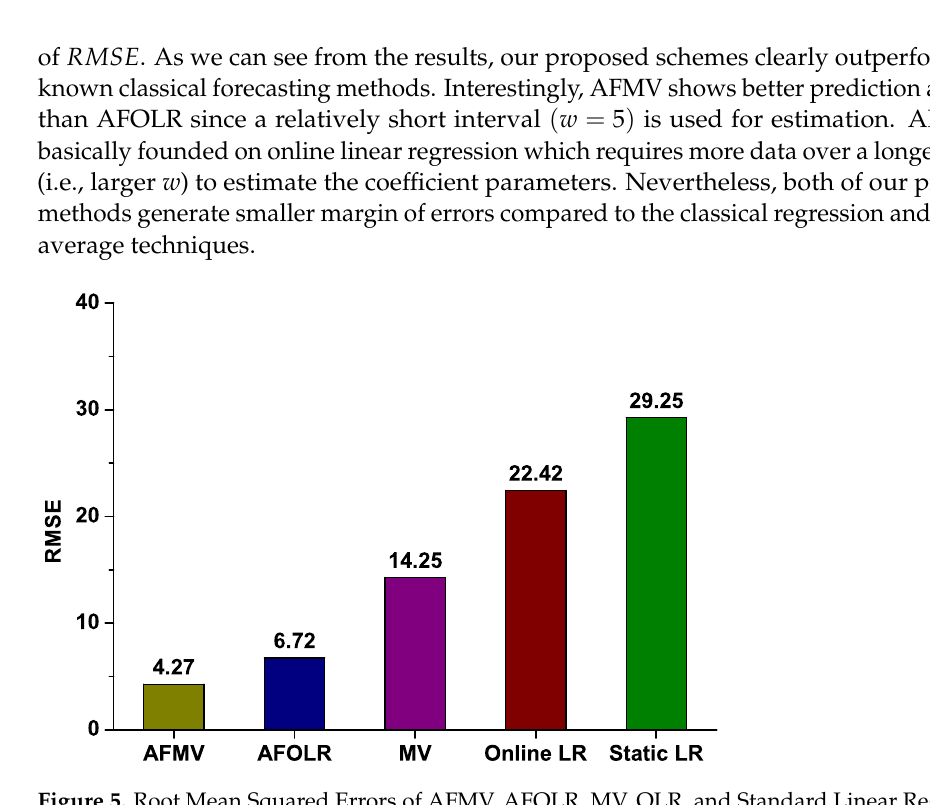
Figure 5. Root Mean Squared Errors of AFMV, AFOLR, MV, OLR, and Standard Linear Regression.